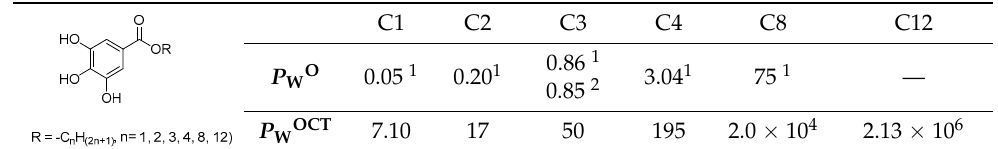
Table 5. Values of the partition constant P WO (olive oil–water) and P WOCT (octanol–water) for several gallic acid derivatives in binary mixtures (determined by employing the Molinspiration software [76],